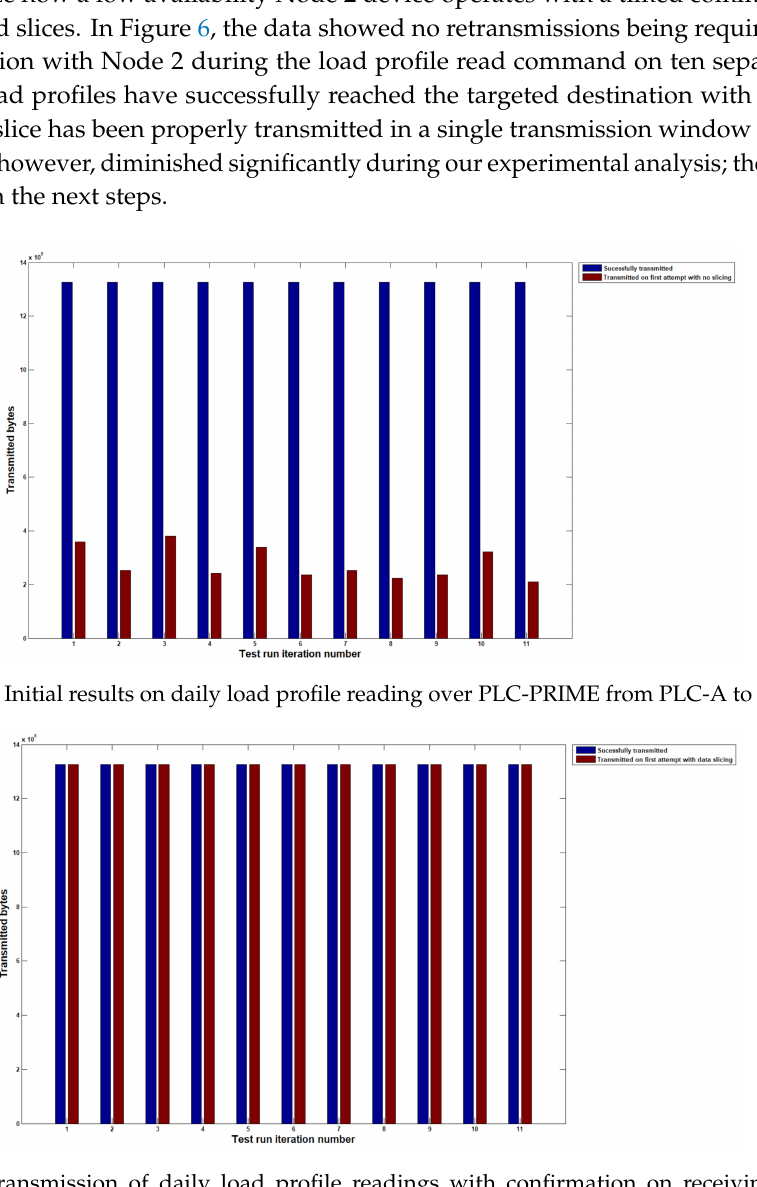
Figure 6. Transmission of daily load profile readings with confirmation on receiving with no retransmissions